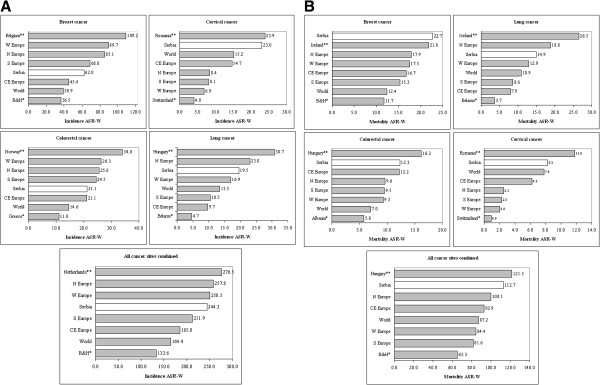
(A) Comparison of Serbian incidence ASR-Ws with the GLOBOCAN 2008 estimates –women; (B), Comparison of Serbian mortality ASR-Ws with the GLOBOCAN 2008 estimates – women. N Europe – Northern Europe, S Europe – Southern Europe, W Europe – Western Europe, CE Europe – Central Eastern Europe. B&H – Bosnia and Herzegovina. * - Eureopan country with the lowest incidence/mortality ASR-W. ** - European country with the highest incidence/mortality ASR-W.